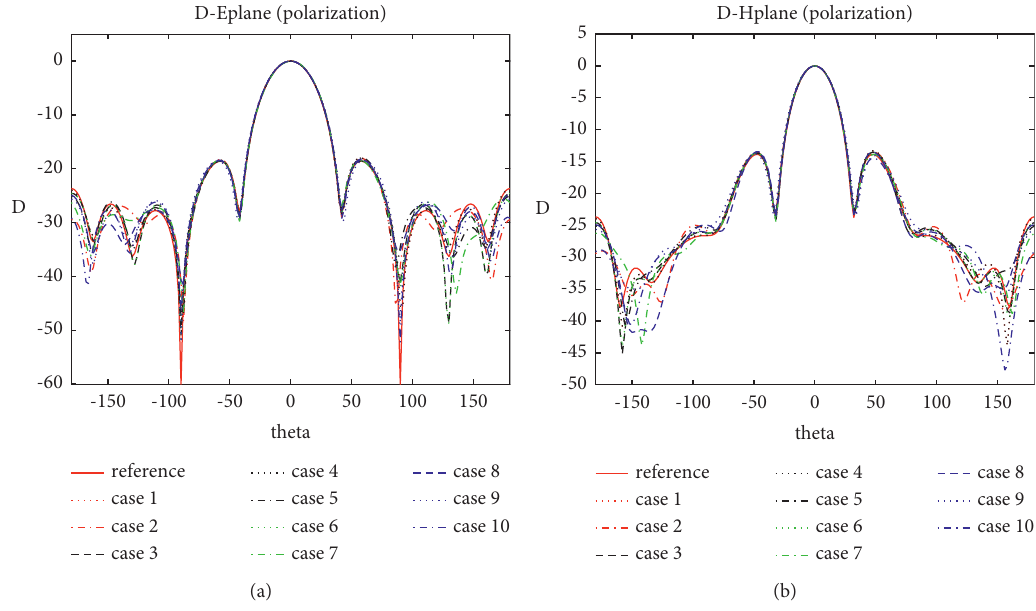
Figure 10: The radiation pattern corresponding to polarization mode described in case 3. (a) E-plane. (b)